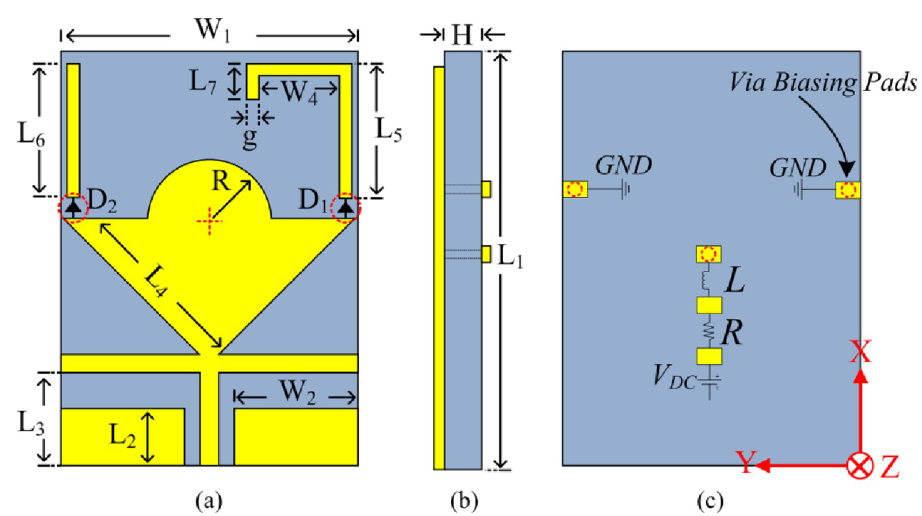
Fig 1. The geometry of proposed CPWfed frequency reconfigurable antenna operating over a wideband including ISM, WLAN and 5G wireless technologies, (a) Front view, (b) Side view, and (c) back view.